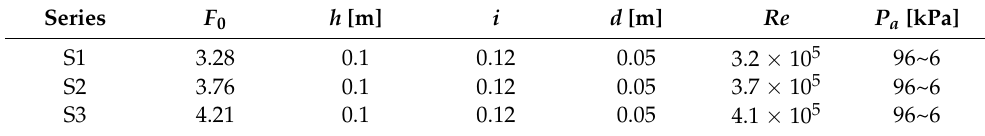
Table 1. Test program and